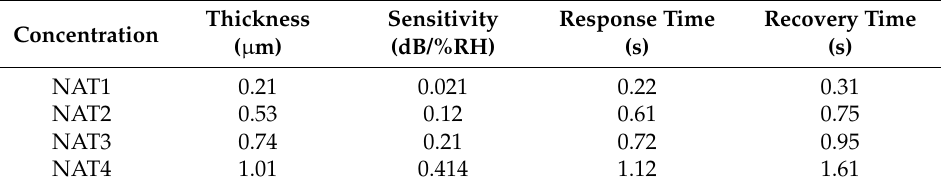
Table 1. Sensitivity and performance of the proposed device using several concentration of TiO 2 as